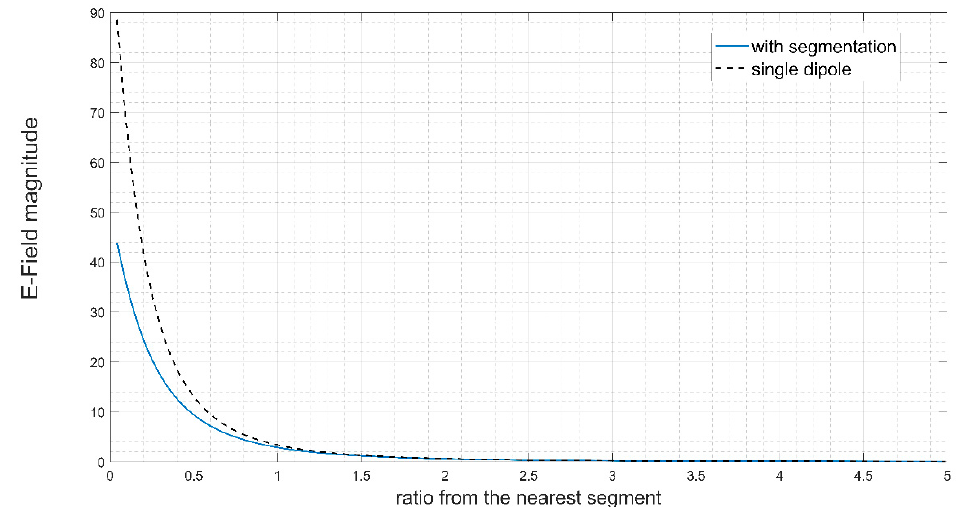
Figure 7. Comparison of the magnitude of the electric field ( E x2 + E y2 + E z2 ) 1/2 versus the ratio of the measurement distance to the cable length, for the Single Dipole Case (dashed line) and the Segmented Cable Case with N = 50 segments (solid line).